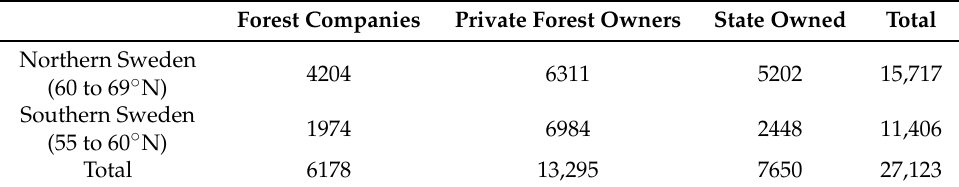
Table 1. Composition of growing stock in major ownership categories (million